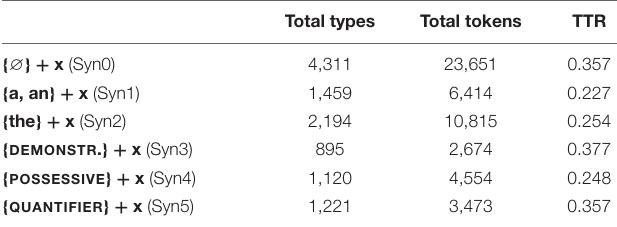
TABLE 5 | Total of nouns in each of the distributional contexts.